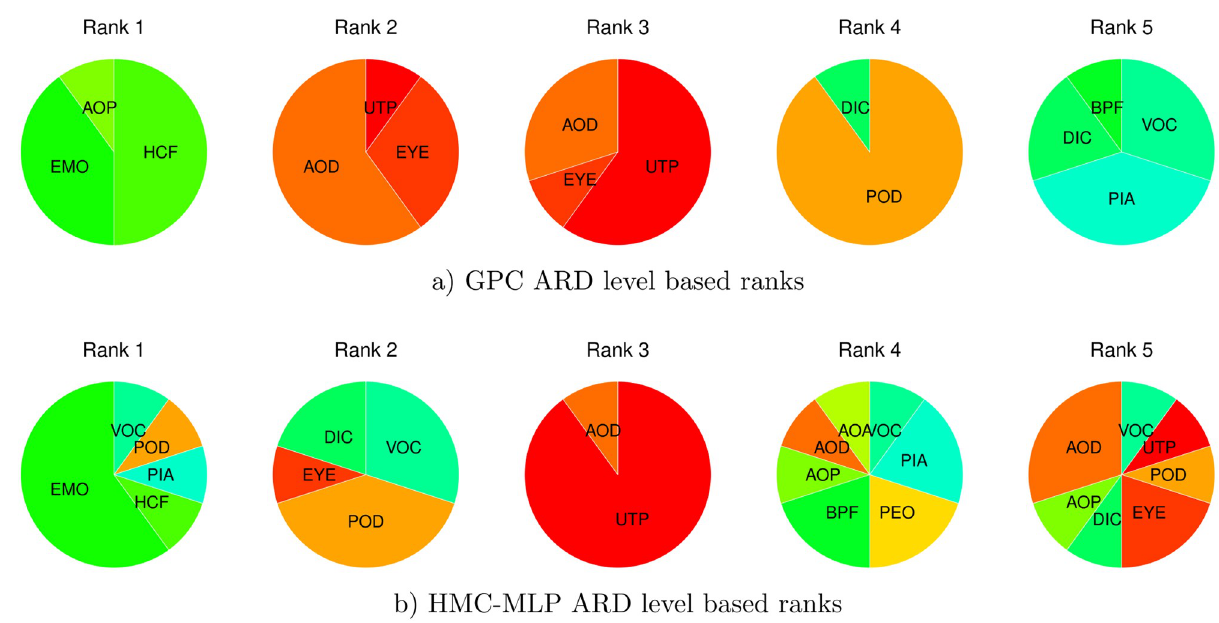
Fig 10. ARD level based ranking of GPA-shape features. The pie charts visualize for ranks one to five the relative number of occurrences of a landmark being ranked at the respective position when repeating inference ten times on reshuffled data. The graph in a) illustrates the ranks which we obtain with GPC based ARD levels. The graph in b) illustrates the ranks which we obtain with HMC-MLP based ARD levels. For improved reproducibility we look for agreement between both rankings to conclude that the upper tip of the snout (UTP), the posterior end of the mouth (EMO), the anterior insertion of the dorsal fin (AOD), and the posterior insertion of the dorsal fin (POD) show signs of differentiation. This suggests that dorsum and snout are affected the most from adaptation.